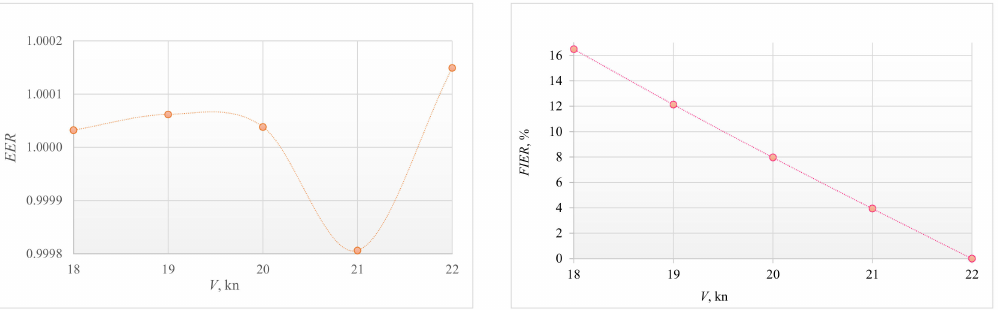
Figure 30. EER for gasification valorization ( left ) and FIER for slow steaming valorization ( right ).